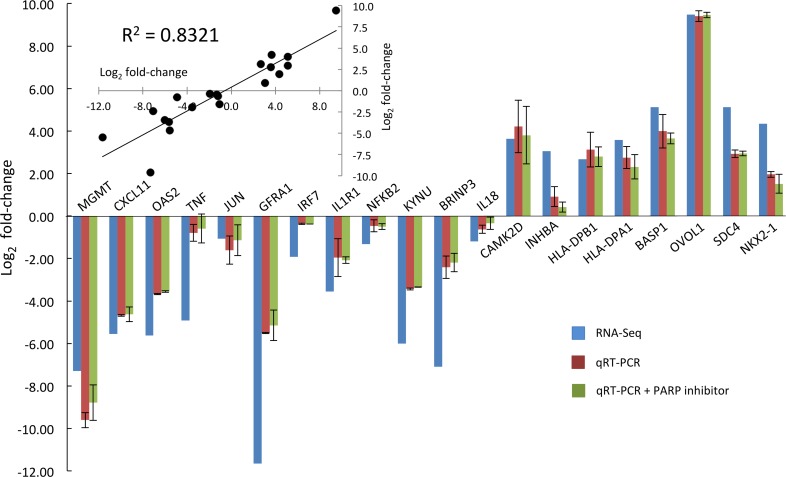
Validation of RNA-Seq data for differential gene expression by qRT-PCR.qRT-PCR analysis was performed on selected RNAs from KBM-7 and NuKO cells in the presence and absence of 100 nM of the PARP inhibitor KU-0058948 using the primers listed in S1 Table as described in Materials and Methods and the log2 fold-change in expression plotted beside those obtained by RNA-Seq analysis. Inset: simple correlation plot of the log2 fold-changes in expression obtained by RNA-Seq (x-axis) and qRT-PCR without PARP inhibitor (y-axis).